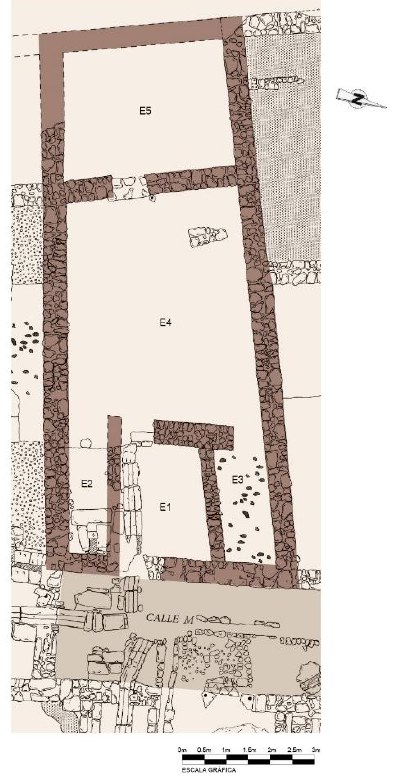
Figure 11. Variant 1. House 124. Plan and room distribution.